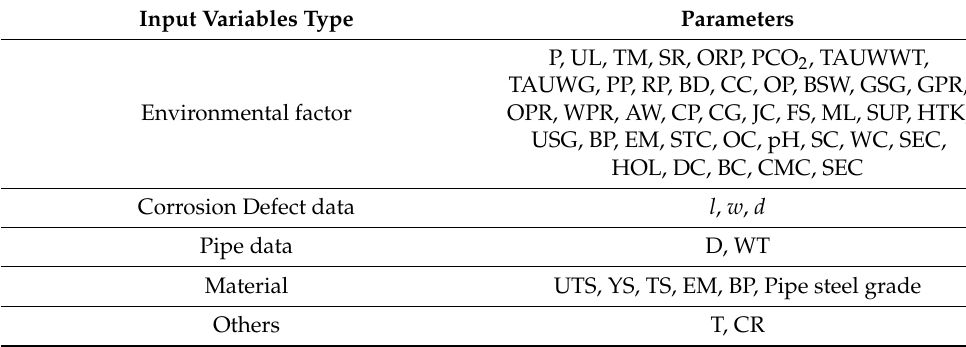
Table 8. The input variables of prediction